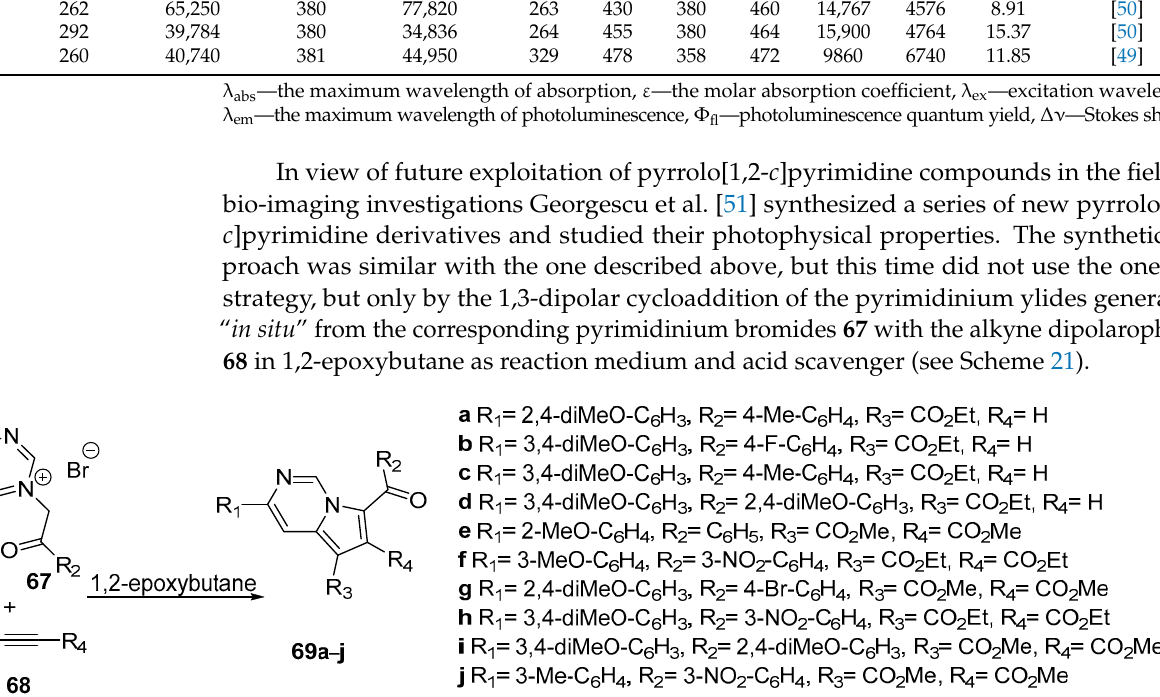
The absorption and emission spectra of compounds 66a – j were recorded in acetoni- calculated (Table 11) for all compounds 66a – j using Equation (1) using quinine sulphate as standard. Table 11. The main spectral features of the compounds 4a – j in acetonitrile:chloroform (1:1). Compound